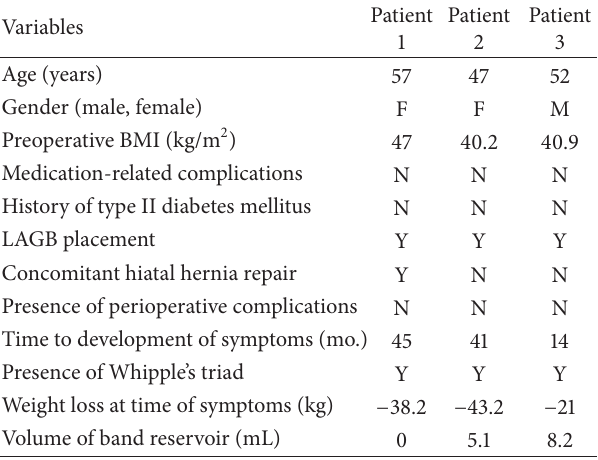
Table 1: Case patients’ characteristics.